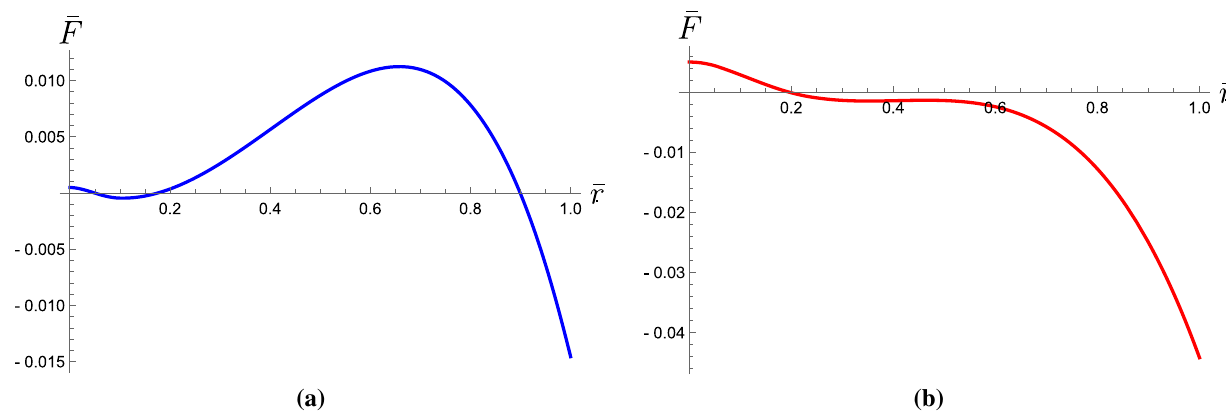
Fig. 6 Free energy is plotted against temperature: black holes with horizon radii small, medium and large are plotted in red, blue and green. a ¯ α = 0, ¯ a = 0 . 1, b ¯ α = 0 . 004, ¯ a = 0 . 2